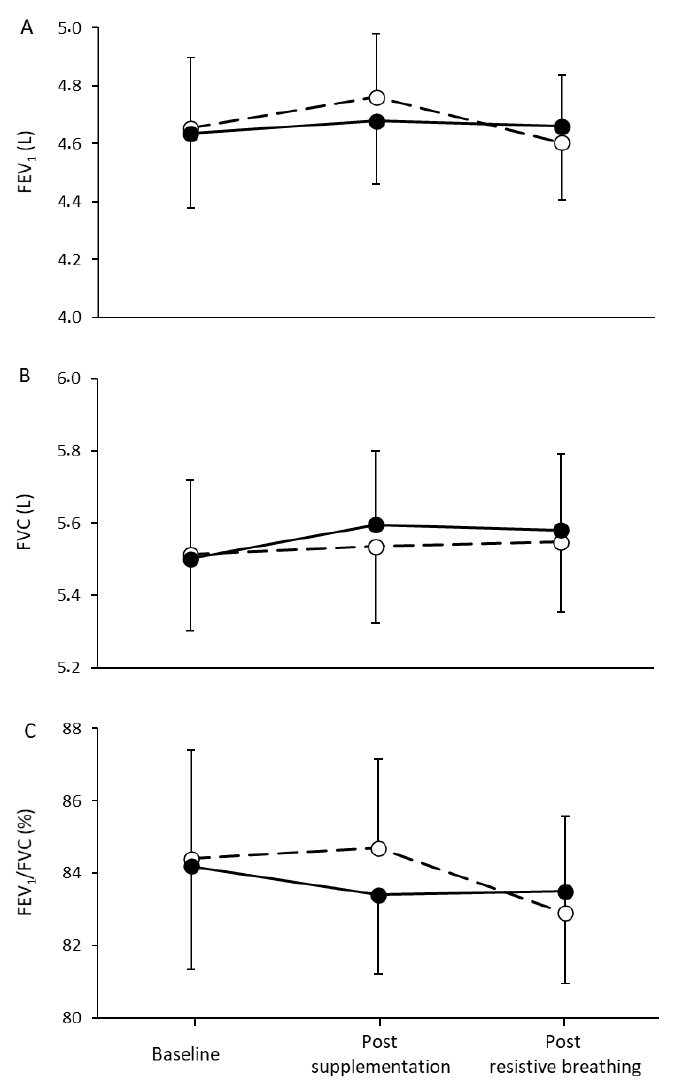
Figure 3. Forced expired volume in 1 second ( A ), forced vital capacity ( B ), and their ratio ( C ) at baseline, one hour post L-citrulline (closed circles) and placebo (open circles) supplementation and after resistive breathing to task failure.